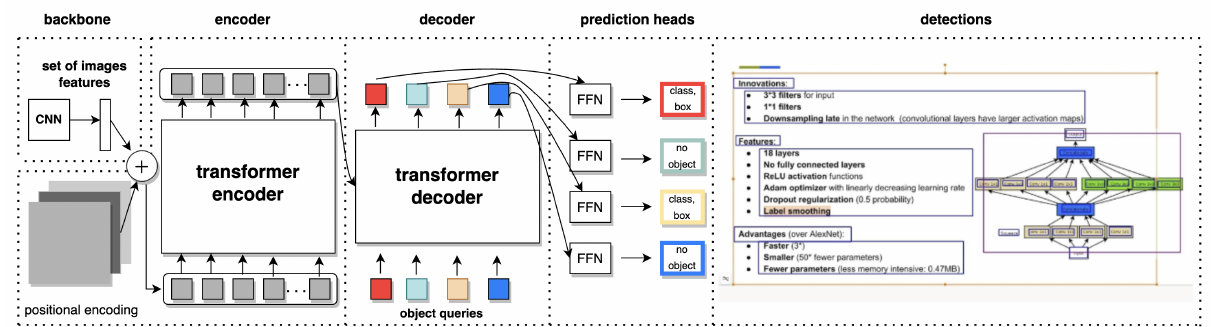
Figure 1. DETR architecture as presented in